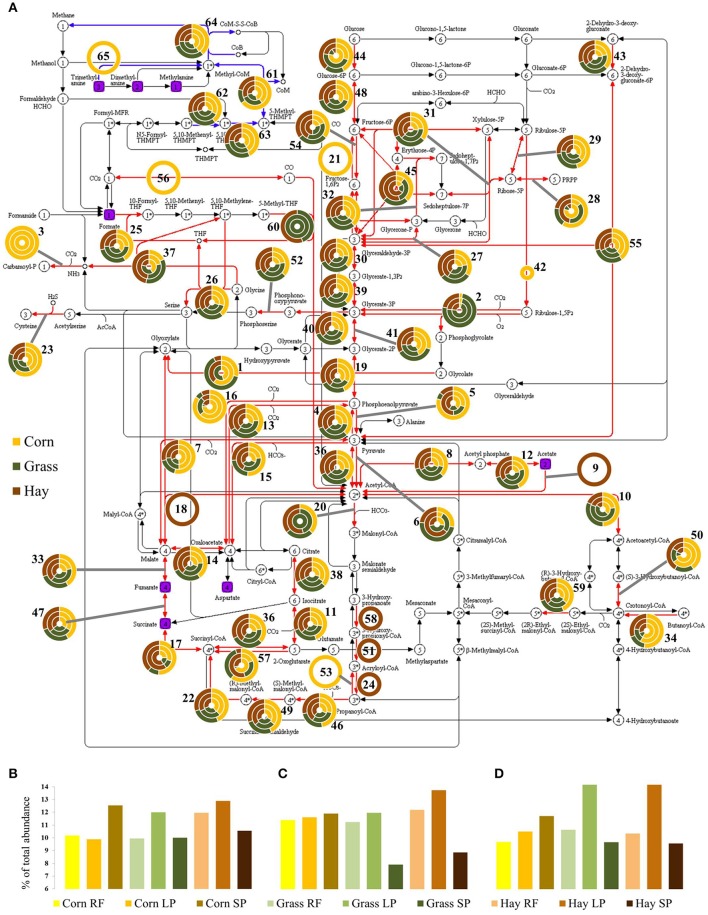
(A) Abundance of archaeal (blue) and bacterial (red) enzymes (n = 3) involved in carbon metabolism, grouped and numbered according to the respective reactions (Table S6). Outer circle, solid phase; middle circle, liquid phase; inner circle, rumen fluid. Purple, compounds identified by NMR. The percentage of total LFQ-values of groups involved in (B) the Embden-Meyerhof-Parnas pathway (5, 19, 27, 30, 32, 39, 41, 44, 48, 54), (C) citrate cycle (11, 14, 17, 33, 38, 47, 57) and (D) pentose phosphate pathway (29, 31, 45, 48). RF, rumen fluid; LP, liquid phase; SP, solid phase.